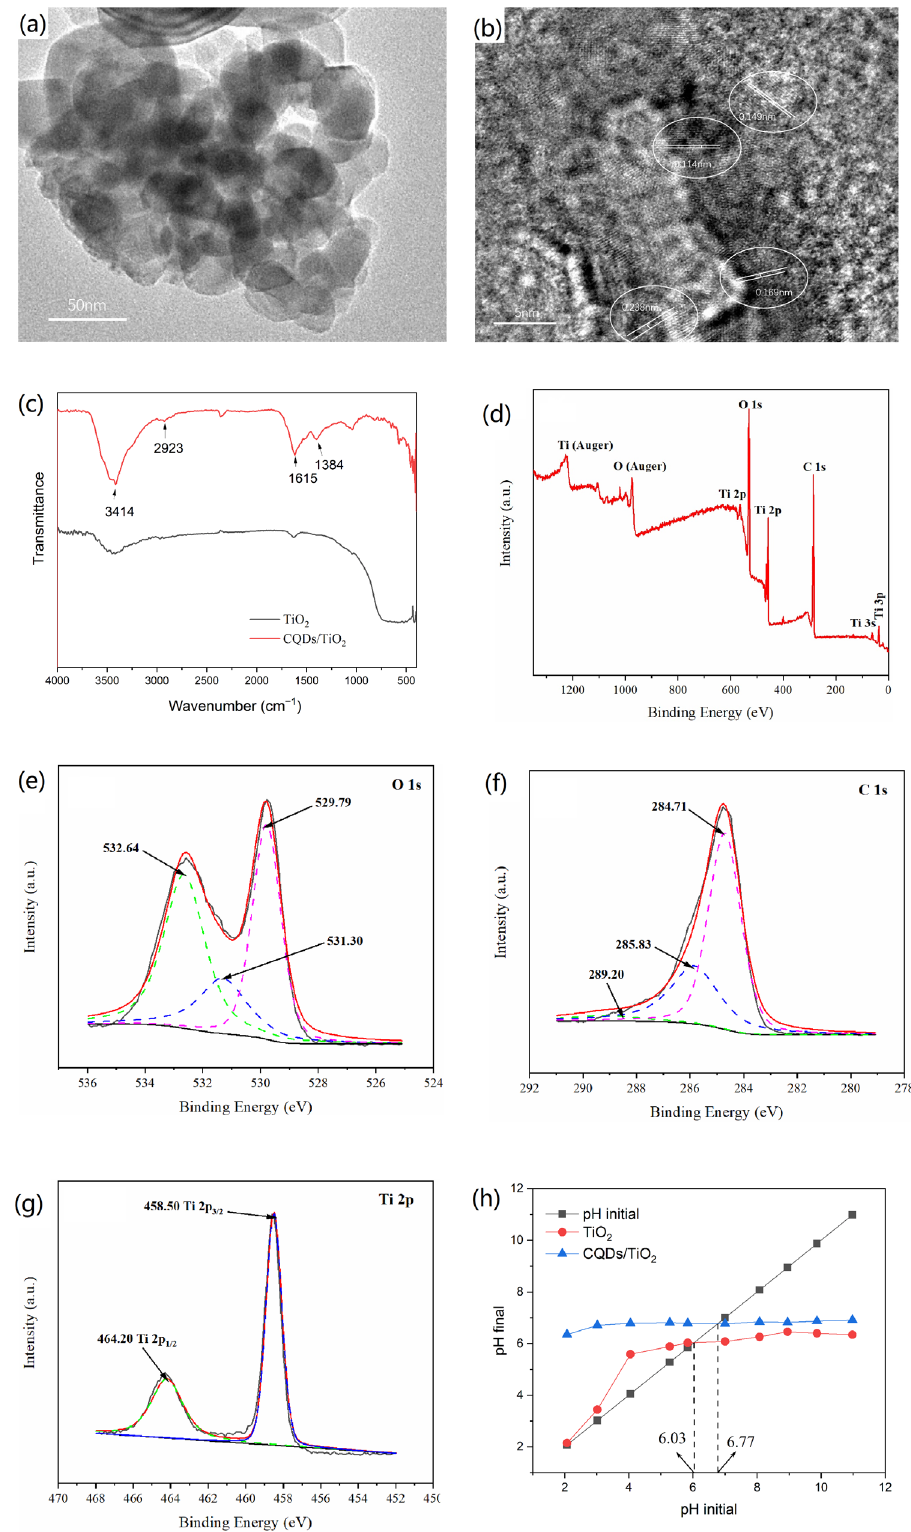
Figure 7. ( a , b ) The TEM image ( a ) and HRTEM image ( b ) of CQDs/TiO 2 composite based on WRN; ( c ) IR spectra pure TiO 2 and CQDs/TiO 2 composite. ( d – g ): The full XPS ( d ), O 1 s ( e ), C 1 s ( f ), and Ti 2p ( g ) high-resolution spectra of CQDs/TiO 2 composite based on WRN. ( h ) PZC of pure TiO 2 and CQDs/TiO 2 composite.